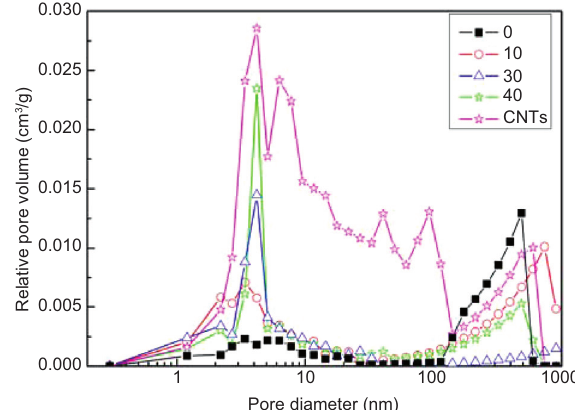
Figure 4 Effect of CNT ratio on pore structures of carbonized